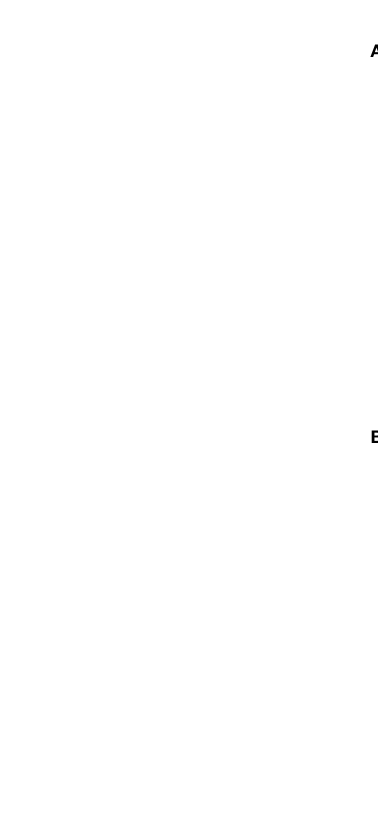
biomass of Navua sedge (r = 0.53; P = 0.006; Figure 5 ); and (iii) the proportion of sand in the soil (r = 0.34; P = 0.009); and was negatively correlated with silt proportion (r = -0.39; P = 0.002) of the soil ( Table 3 ). The positive correlation between the abundance of Navua sedge seeds in soil with that of aboveground biomass of Navua sedge is mainly driven by two